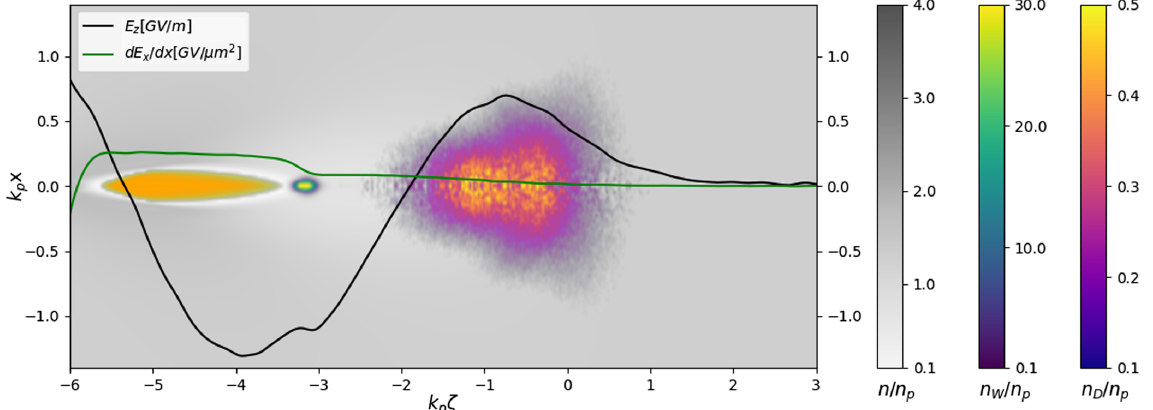
FIG. 1. A simulation of the proposed scheme using the code ARCHITECT . The snapshot is taken at 1 cm inside the plasma channel. In this case we used a background plasma with a density n p ¼ 2 × 10 16 cm − 3 . The coordinate system is in the reference frame of the laboratory, comoving with the center of the driving bunch. The beams are axially symmetric bi-Gaussian shaped. The driver has a low density n b =n p ≈ 1 , and the witness has a high density n b =n p ≫ 1 . The accelerating field E z is represented in black and the transverse derivative of the focusing field E x is represented in green. The longitudinal compensation of energy spread occurs in correspondence of the witness. The magnitude of the transverse field in this region is lower than in the blowout region (marked in orange behind the witness) and is the result of the combination of the focusing field of the driver and the self-focusing generated by the witness itself.